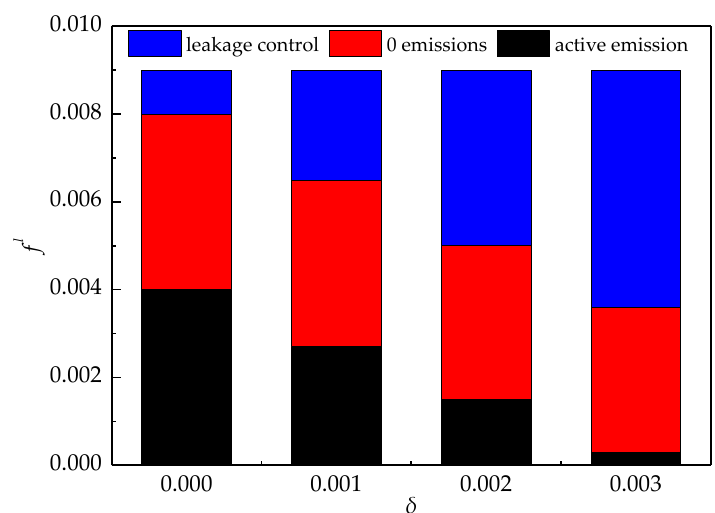
Figure 7 . Optimal operating strategy for systems with different impurity removal rates.